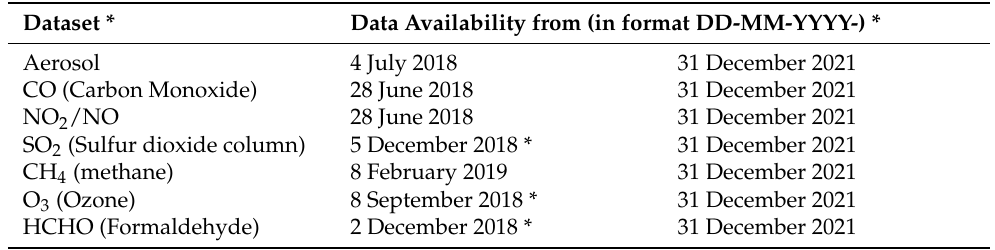
Table 1. Types of Atmospheric pollutants and data availability period through Sentinel-5P TROPOMI instrument. Dataset *